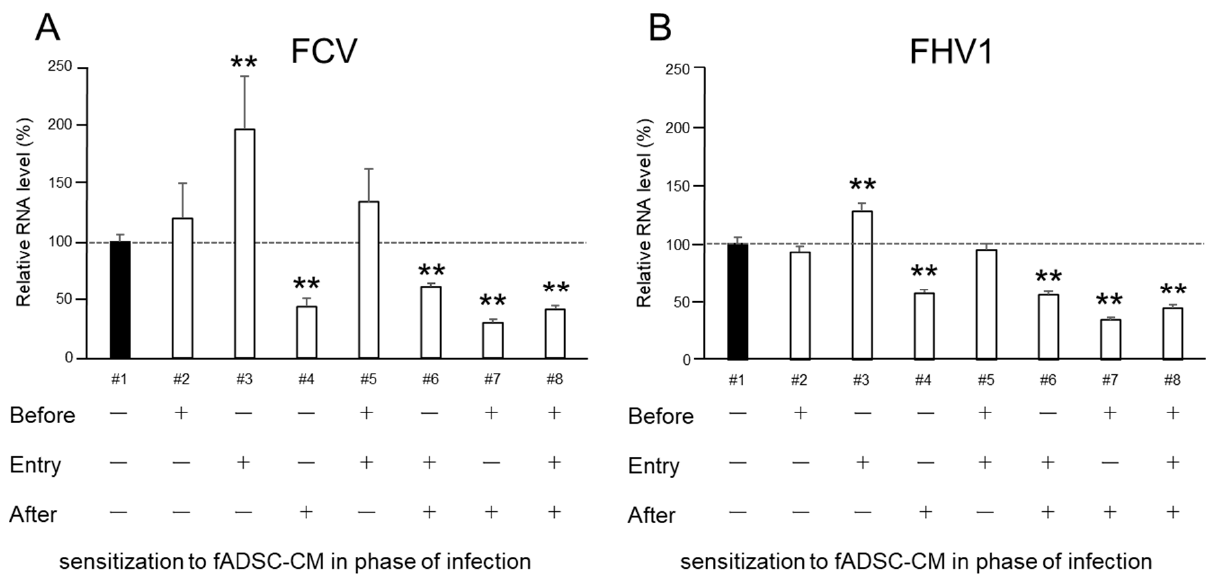
Figure 5. Effects of fADSC-CM on viral replication in CRFK cells cultured with (+) or without ( − ) naïve fADSC-CM before viral infection, during infection (attachment and entry), and/or after infection ( A ) Relative FCV viral mRNA levels in CRFK cells. ( B ) Relative FHV1 viral mRNA levels in CRFK cells. Data are expressed as the mean ± standard deviation. Asterisks indicate significant differences compared with mock-treated group (**, p < 0.01).